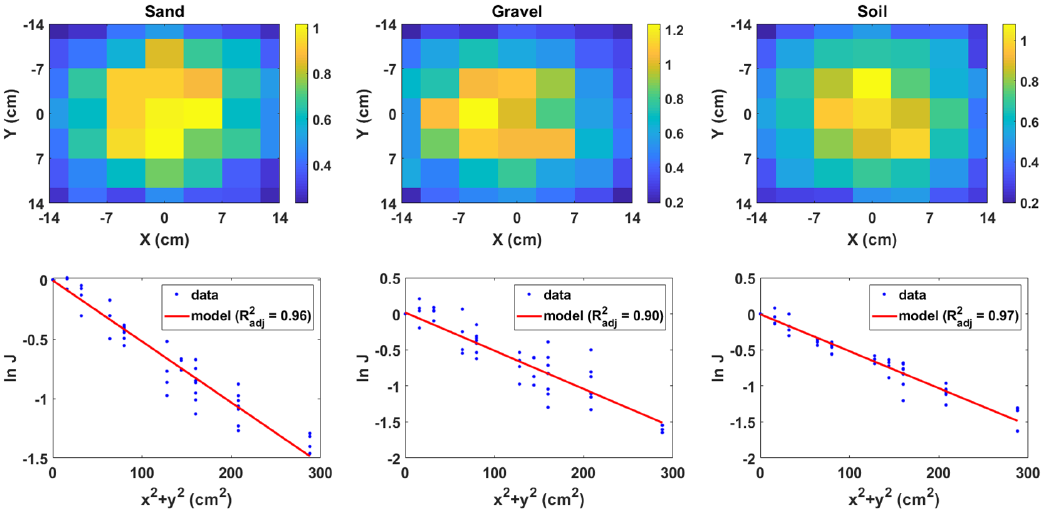
Figure 7. Normalised raster images of the Cs-137 source buried at a depth of 14 cm for each of the material (top row). Corresponding fit of the attenuation model for each of the depth images (bottom row).